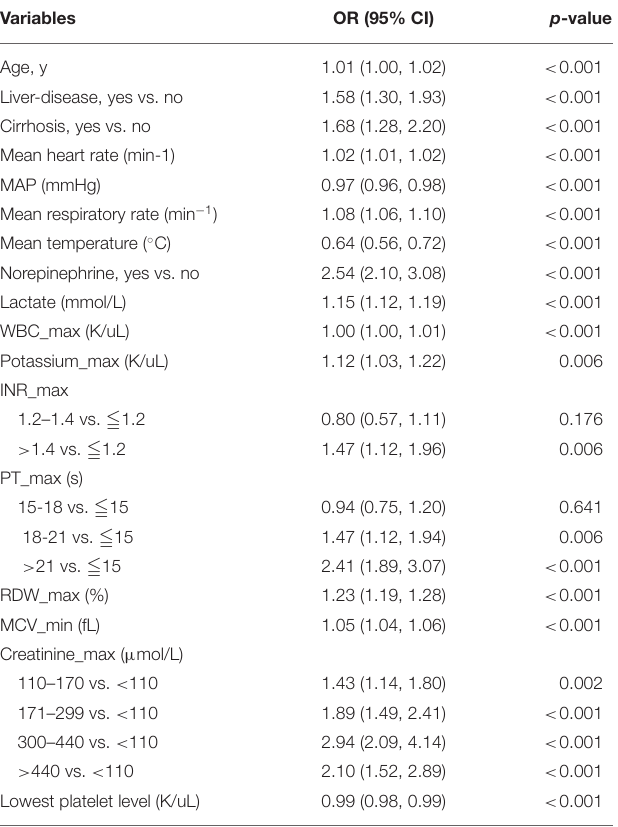
TABLE 3 | Factors independently associated with 28-day mortality of patients with SIC by multivariate logistic regression analysis in training cohort. Variables β